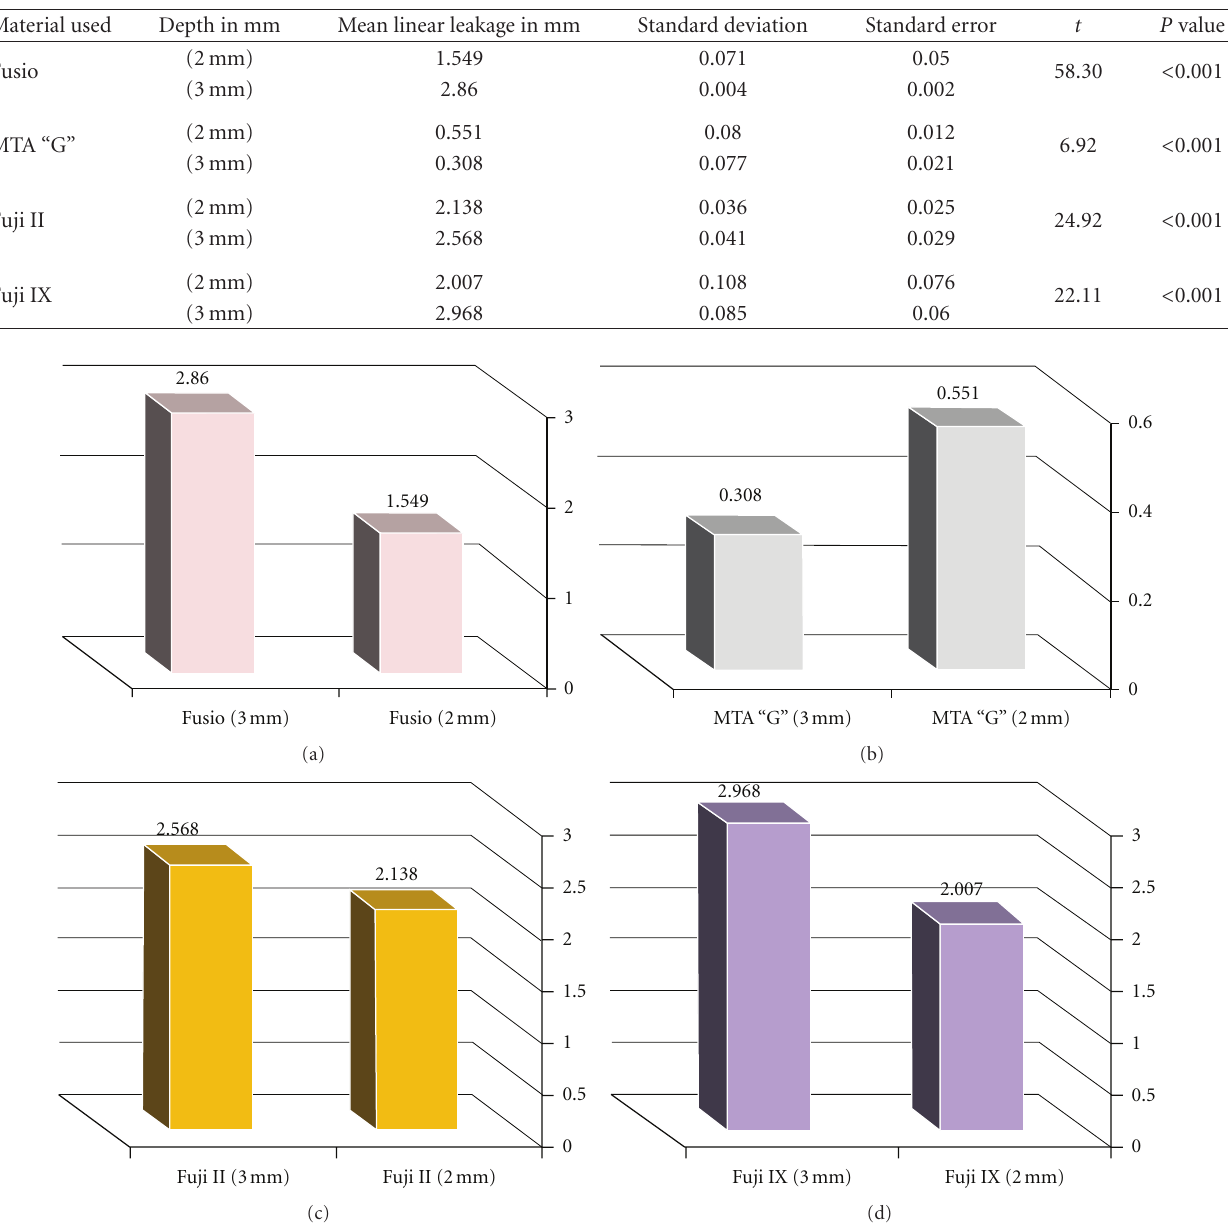
Table 1: Descriptive statistics of linear leakage results in mm for the four tested materials at the two specified orifice depths.